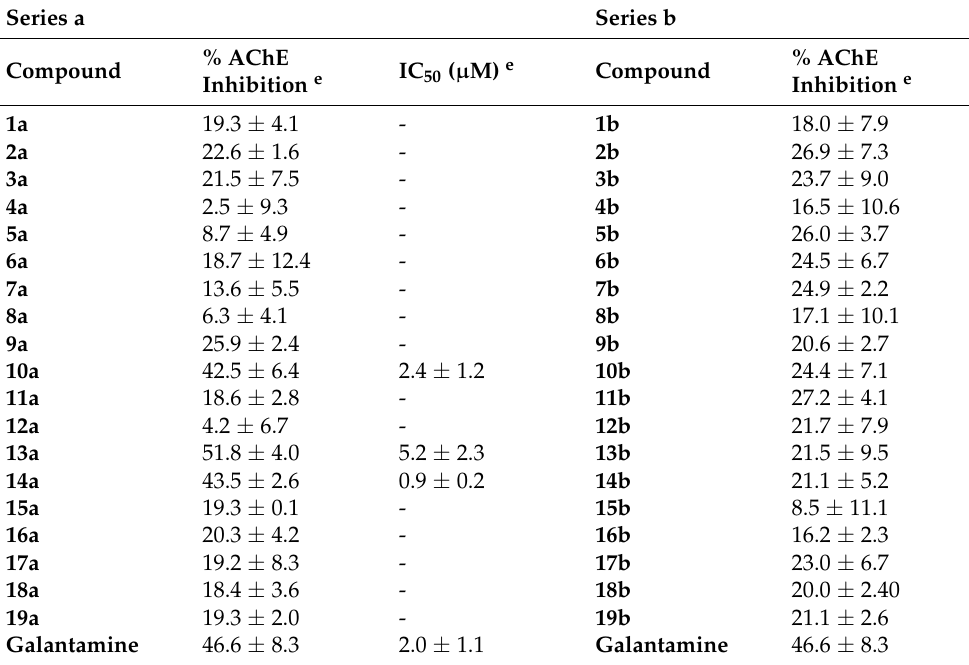
Table 4. Inhibition % of AChE at 10 − 6 M and IC 50